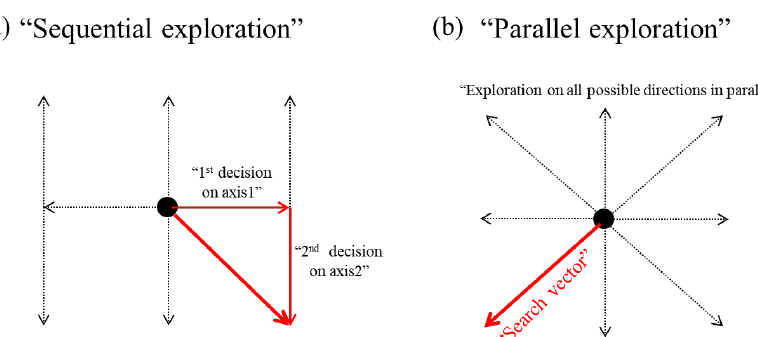
Figure 5. ( a ) The concept of sequential exploration. In each axis of parameter space, ternary explo- ration, thus +step size, 0 or − step size from the exploration basis (black dot) is performed and decide the direction for the axis. Then same process is performed on the following axis. ( b ) The concept of parallel exploration. The all-possible directions in the ternary exploration are evaluated in parallel at the same time and find the best direction among them.